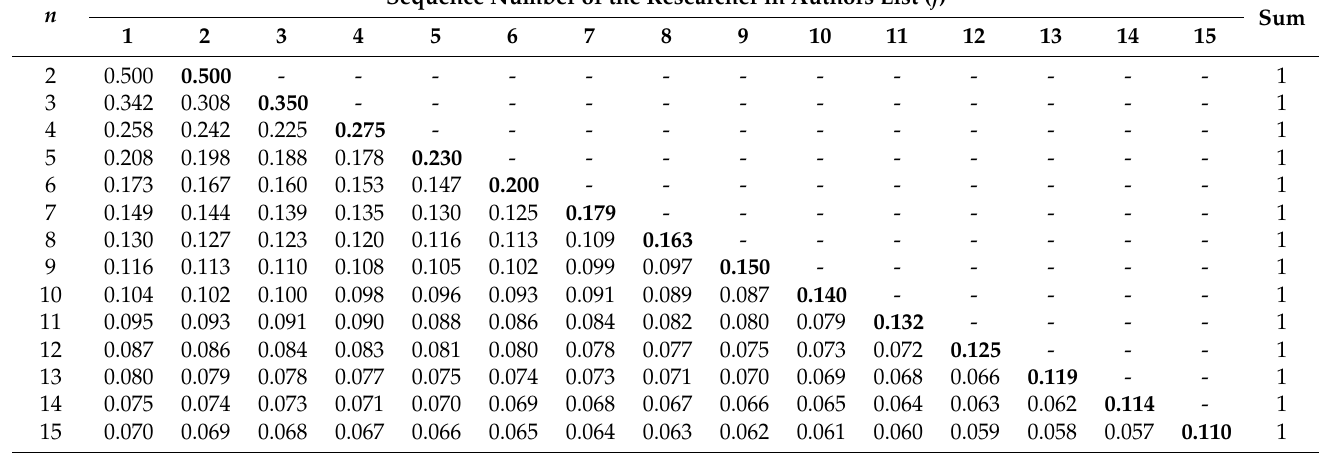
Table 4. Uniformly decreasing distribution of fractional credit shares of a publication among the coauthors (2–15) with the corresponding author (the one in the last entry—shown as bold—of each row) getting an extra 5% credit (C = 5). k = 0.2.